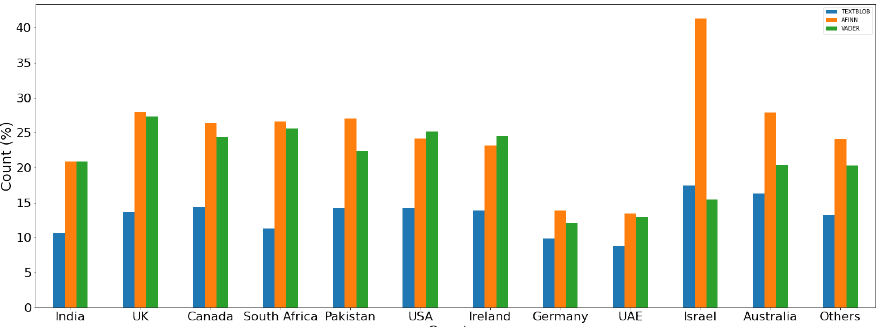
Figure 15. Negative sentiment (%) using each lexicon-based approach.